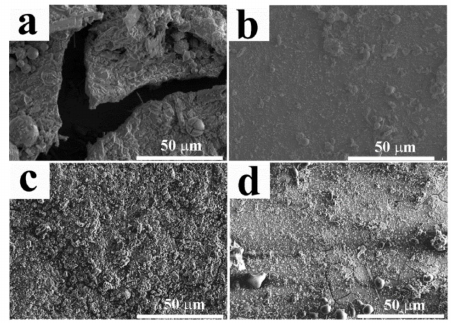
Figure 7. SEM images of ( a ) A 0 , ( b ) A CS1 , ( c ) A CS2 , and ( d ) A CS3 after corrosion.